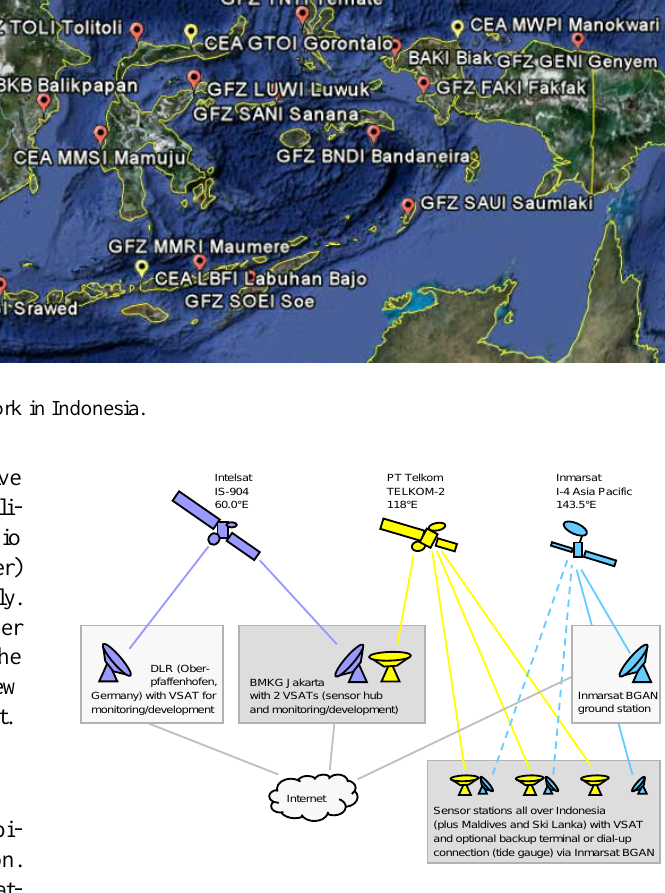
Fig. 7. Three satellite systems are used in GITEWS for different